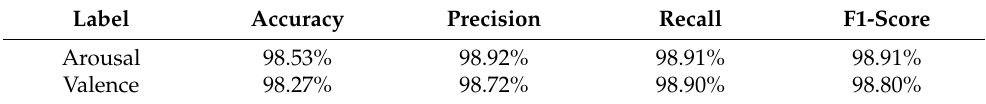
Table 6. The evaluation metrics scores of